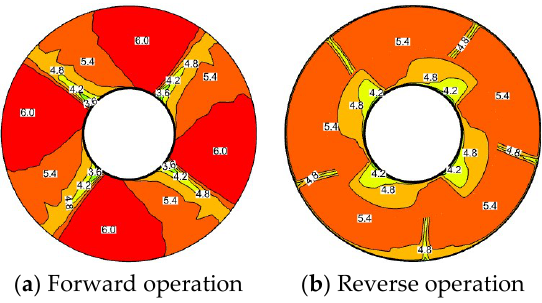
Figure 17. 1.0 Q d impeller inlet axial flow velocity distribution cloud diagram.